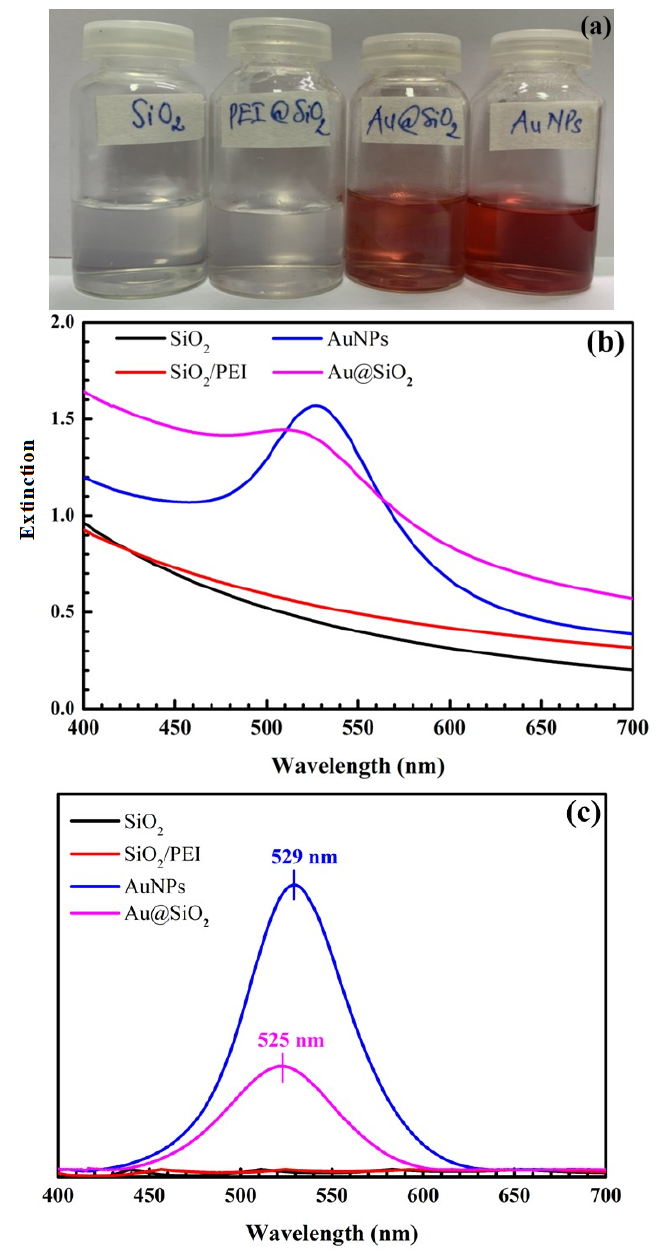
Figure 5. Pictures of SiO 2 , SiO 2 @PEI, AuNPs, and SiO 2 @Au synthesized under optimal conditions ( a ). UV-Vis spectra of SiO 2 , SiO 2 @PEI, AuNPs, and SiO 2 @Au synthesized under optimal conditions ( b ) and their UV-Vis baseline spectra ( c ).